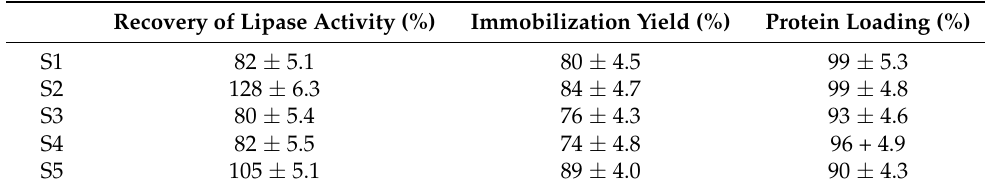
Table 1. Evaluation of the immobilization efficiency of the prepared bio-composites. (The experimen- tal data were determined in